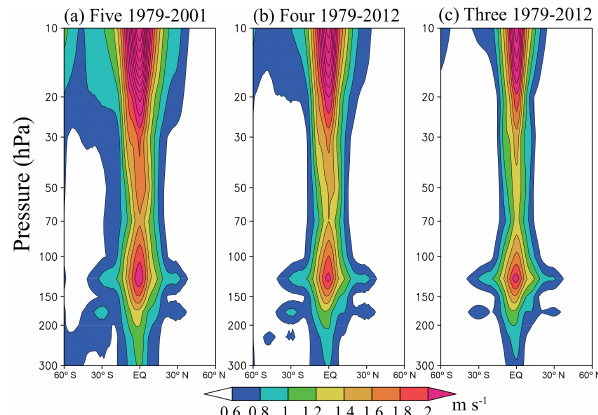
Figure 3. Latitude–height cross sections of zonal mean and time mean of the standard deviation among (a) five reanalyses of ERA- 40, ERA-I, JRA-25, JRA-55, and MERRA from 1979 to 2001; (b) four reanalysis of ERA-I, JRA-25, JRA-55, and MERRA from 1979 to 2012; and (c) three reanalysis of ERA-I, JRA-55, and MERRA from 1979 to 2012. The color intervals are 0.2ms − 1 and shaded with values larger than 0.6ms − 1 .